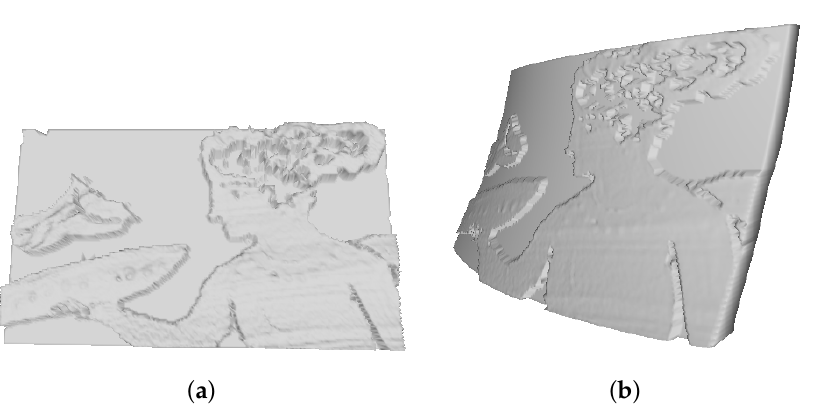
Figure 15. ( a ) Printing simulation of the red figure with an amplified texture, placed in relief on a plane once it is extracted thanks to the reflectance values. ( b ) Printing simulation of the extracted red figure placed in relief on the original